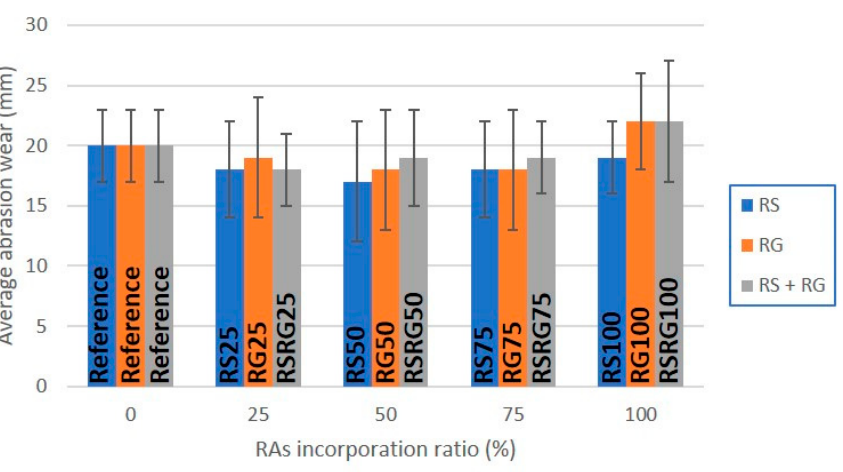
Figure 8. Graphical representation of the average abrasion wear vs. RAs’ incorporation ratio in pavers.